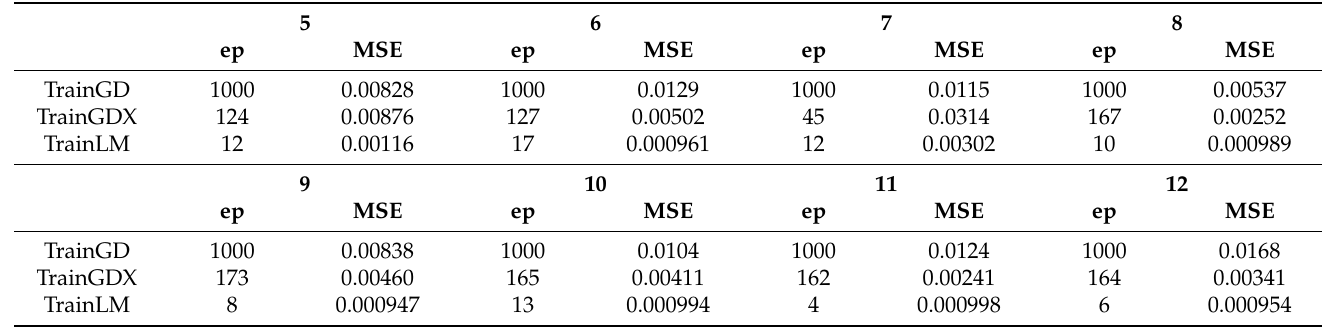
Table 4. The number of neurons in different hidden layers and the corresponding iterative times and errors of the learning algorithms.